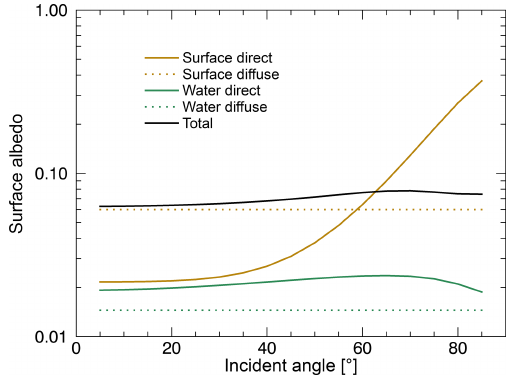
Figure 4. Parameterised ocean surface albedo for a non-glint con- dition and its albedo components due to direct and diffuse surface reflection and direct and diffuse water volume scattering as a func- tion of incident